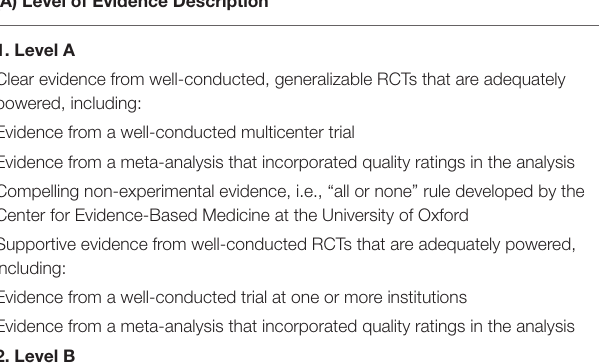
TABLE 2 | American Diabetes Association for prevention of type-2 diabetes [summarized from ref